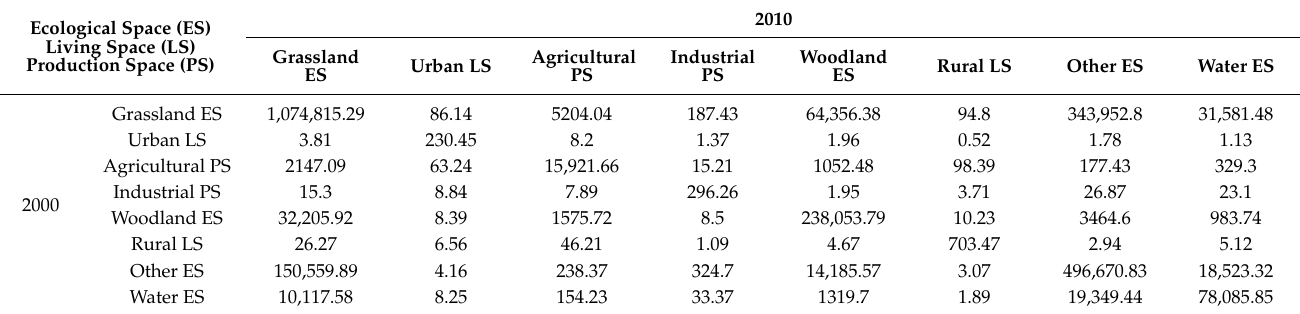
Table A3. Transfer matrix of land use structure change from 2000 to 2010 (km 2 ).